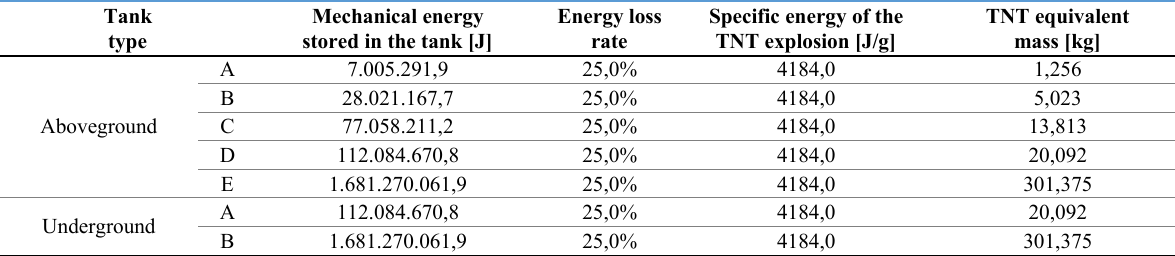
Table 7. Stored energy and TNT equivalent mass in each tank type.